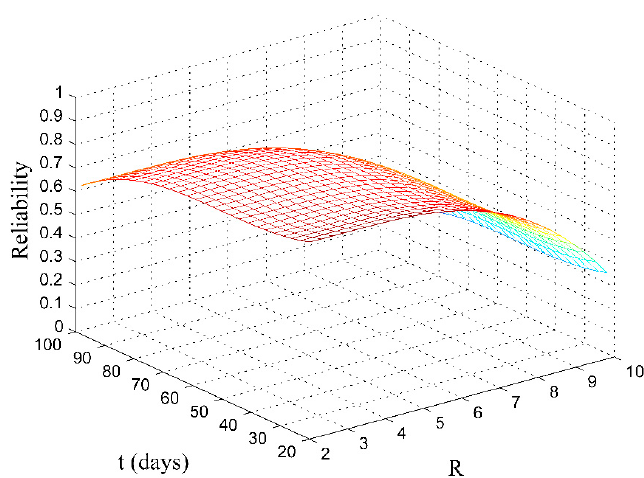
Figure 6. Reliability under different decision variables.